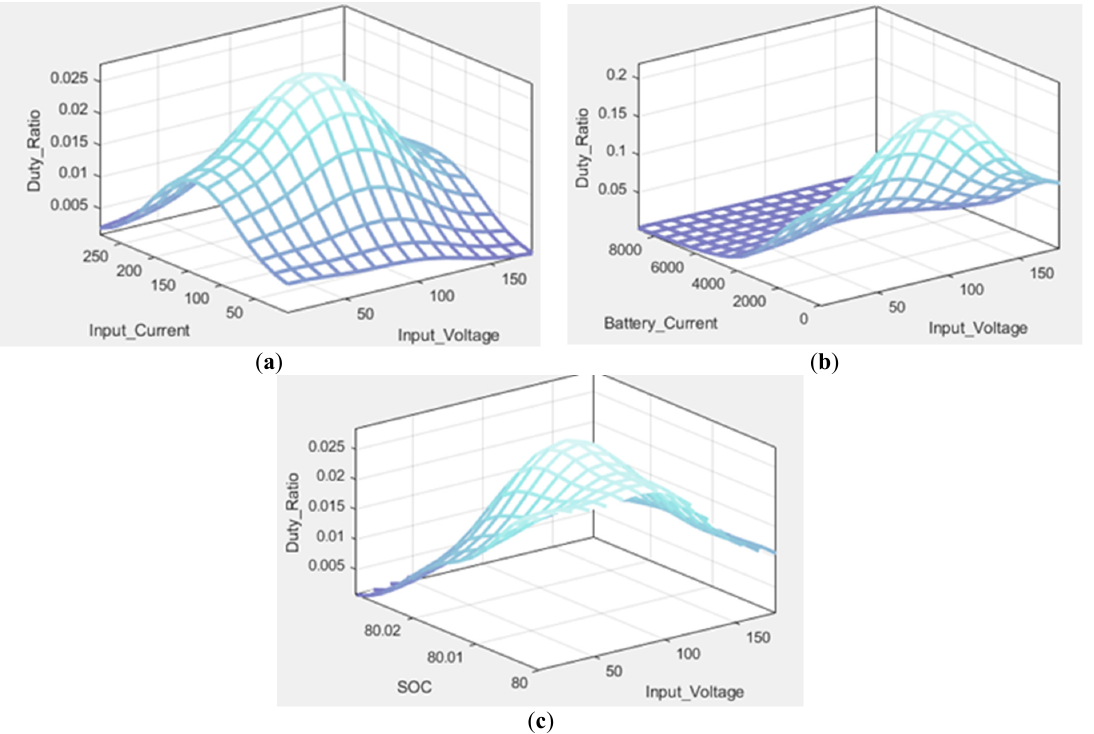
Figure 36. Surface representation for the variables ( a ) input current, input voltage and duty ratio, ( b ) battery current, input voltage and duty ratio ( c ) SOC, input voltage and duty ratio.